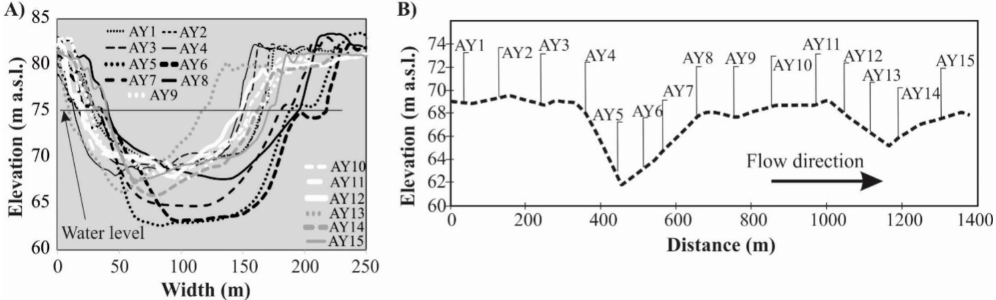
Figure 8. Cross-sectional channel profiles ( A ) and longitudinal thalweg profile ( B ) at the Á ny á s study